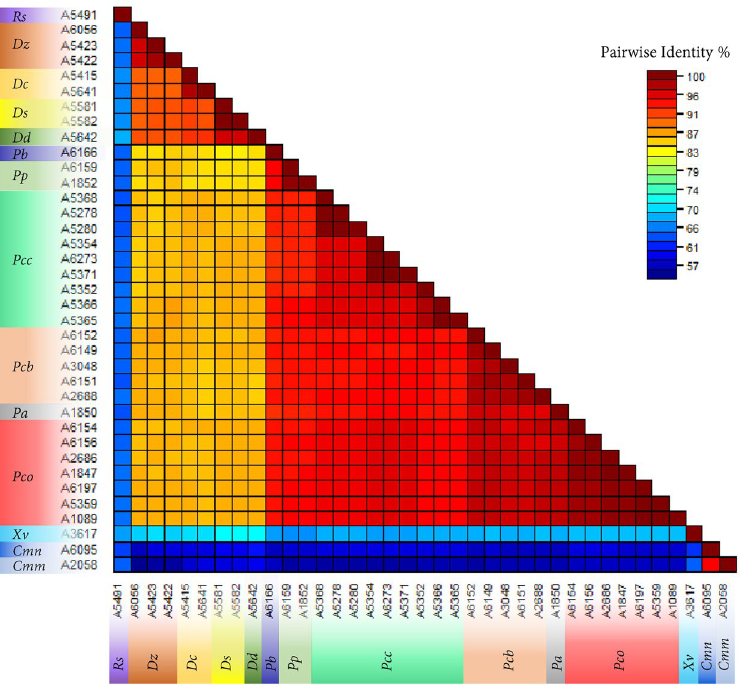
Figure 4. Consensus sequences of dnaA gene were used to generate pairwise color-code similarity matrix. All the strains used in inclusivity and exclusivity panels were included in these analyses; strain descriptions are shown in Table 1. The Sequence Demarcation Tool v1.2 was used to calculate percent pairwise similarity. Rs – Ralstonia solanacearum; Dz – Dickeya zeae; Dc – D . chrysanthem i; Ds – D . solani; Dd – D .